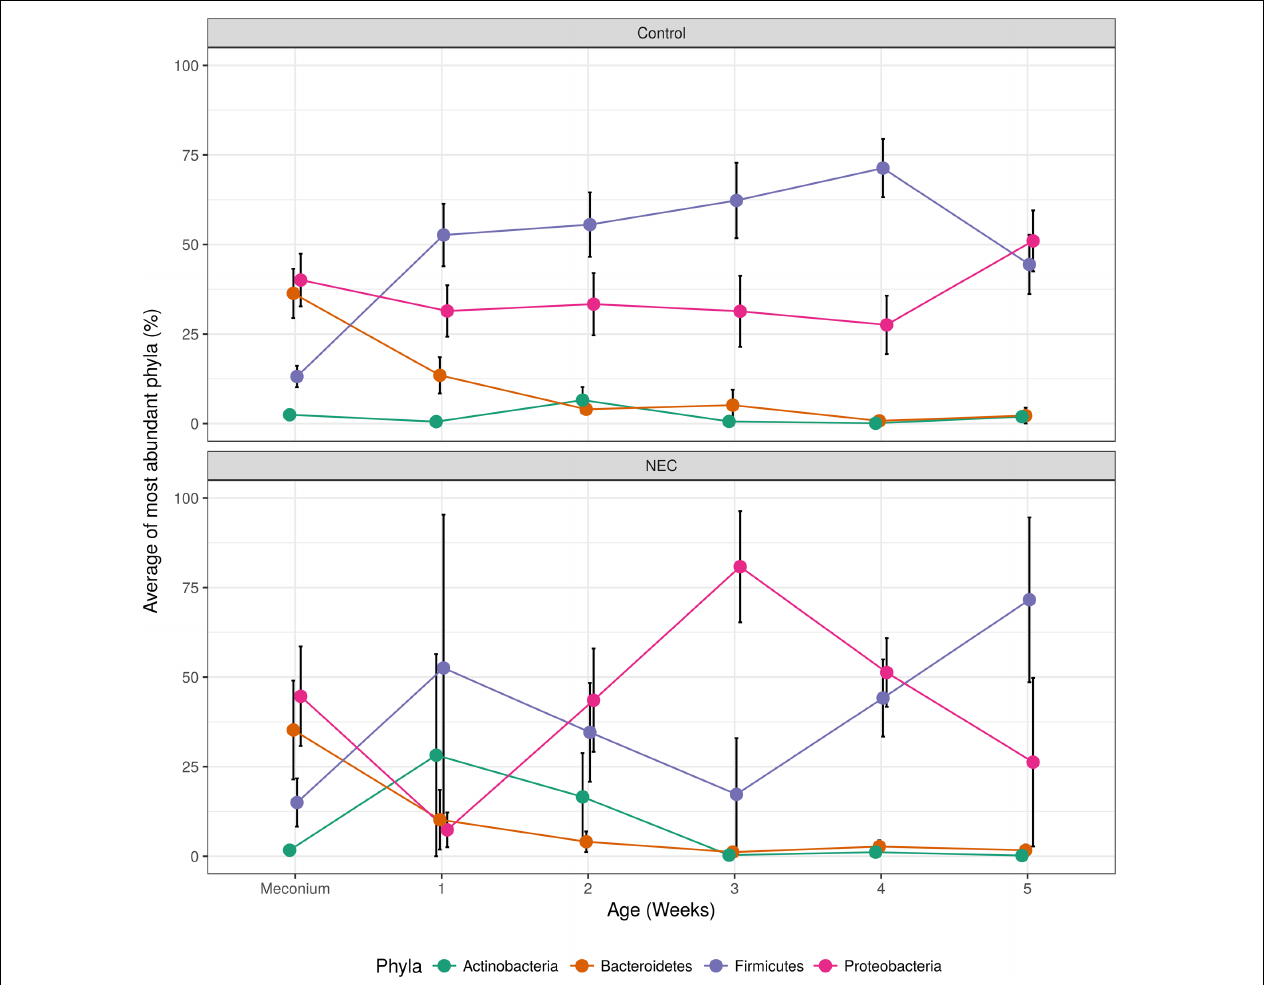
FIGURE 4 | Over time changes of most abundant microbial phyla found in controls (top) and NEC (bottom) . The black vertical bars indicate the standard error of the